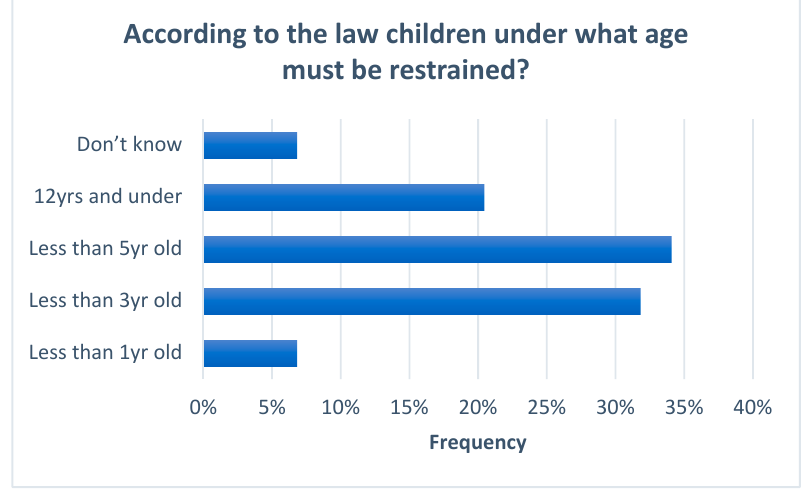
Figure 2. Survey respondent knowledge of current South African law on child restraints. Respondent knowledge of child restraint legislation in South Africa. (NB Correct age according to the law is “Less than 3yrs old”).